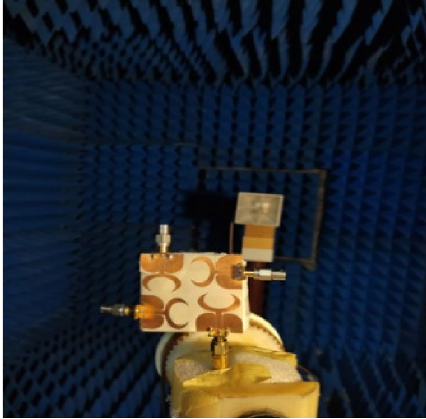
Figure 10. Radiation patterns testing setup of the flexible MIMO in flat configuration inside the anechoic chamber.